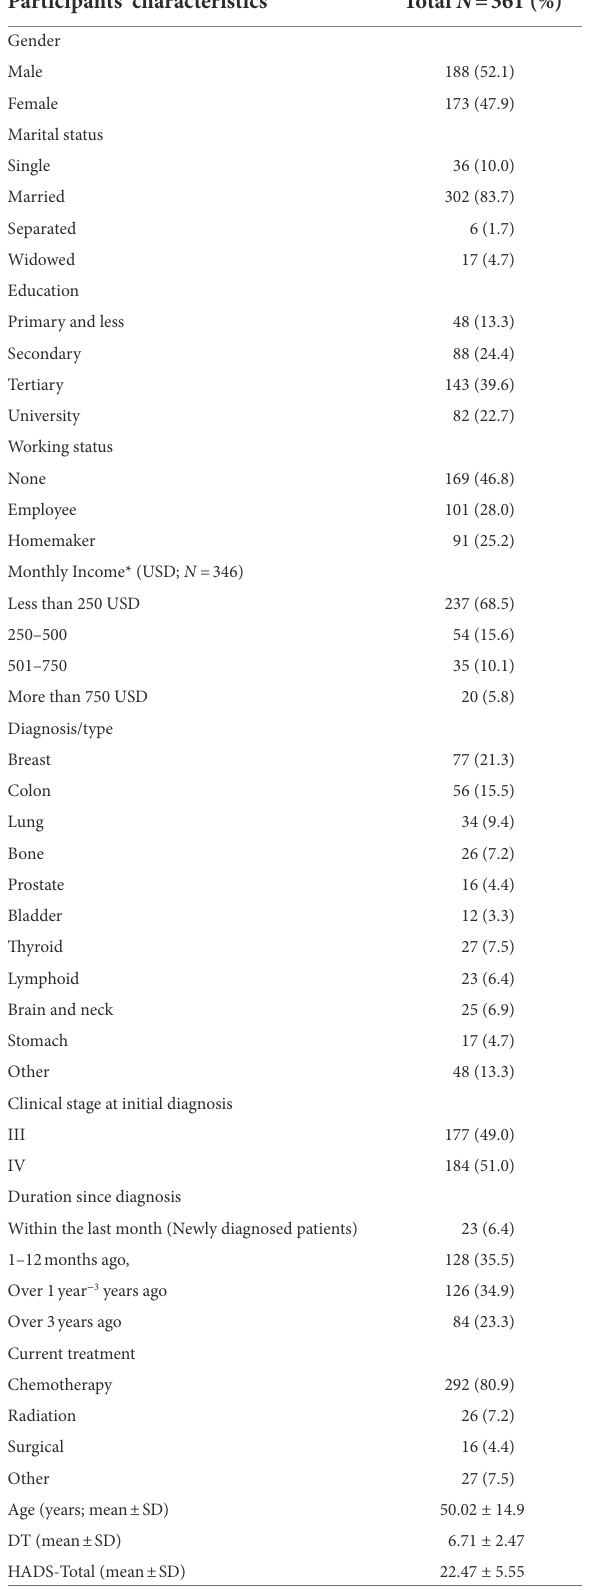
TABLE 1 Sociodemographic and clinical characteristics of participants ( N = 361). Participants’